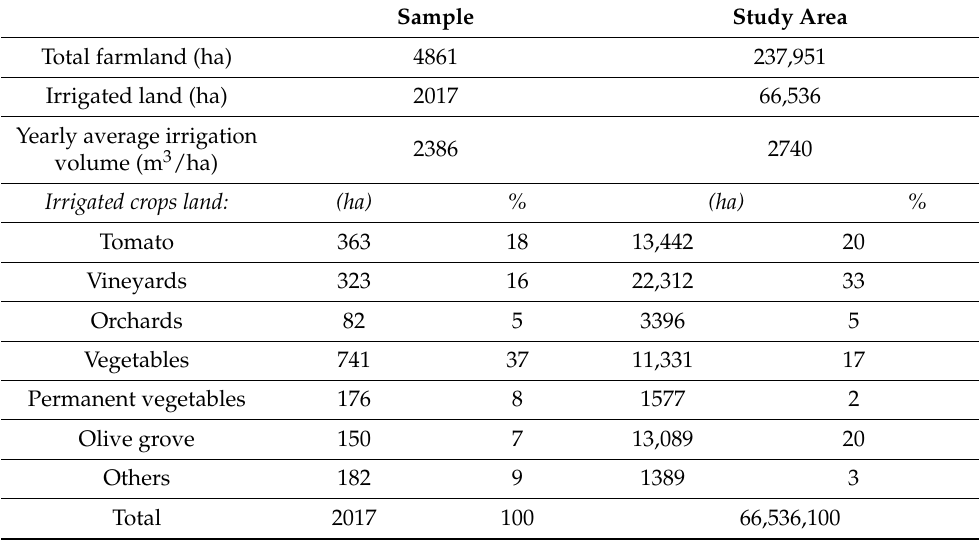
Table 2. Sample representativeness.